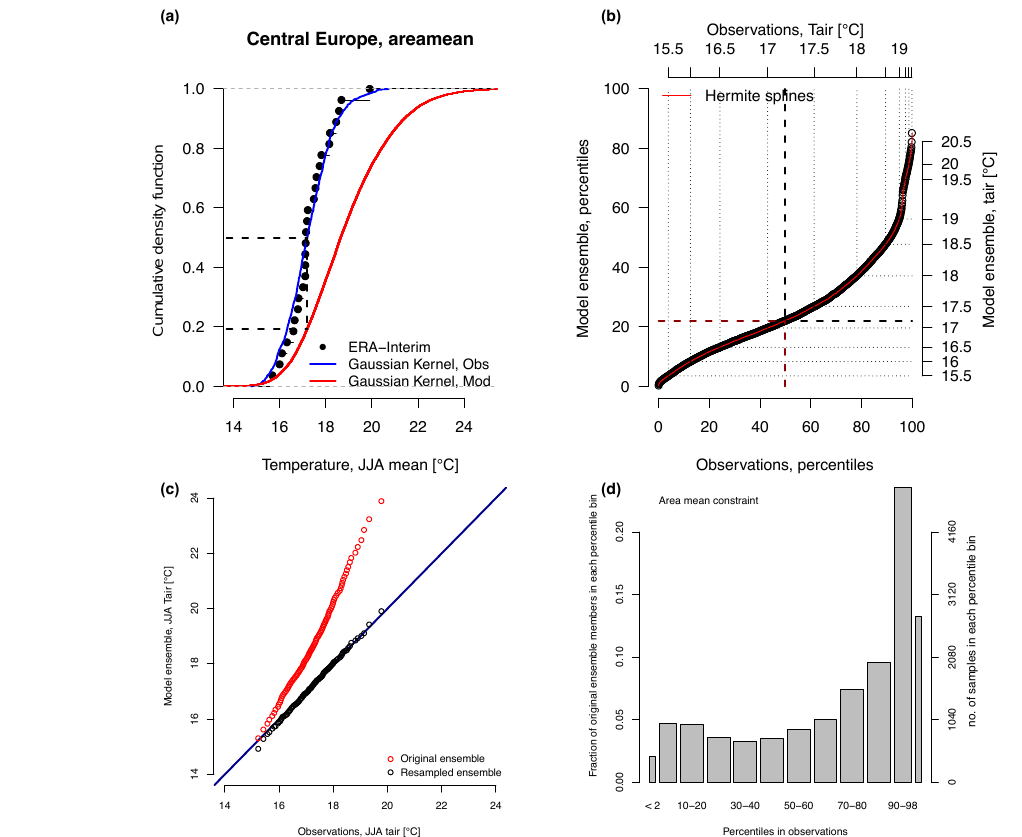
Figure 2. Illustration of ensemble-based resampling methodology. (a) Empirical cumulative density function of JJA mean temperatures over Central Europe in ERA-Interim. The nonparametric fit to the cumulative density using a Gaussian kernel for observations and the model ensemble are shown by the blue and red lines, respectively. (b) A transfer function between the observed and modelled distribution is derived using Cubic Hermite splines. (c) Quantile–quantile plot for the original and resampled ensemble for the JJA temperature constraint. (d) Fraction of original ensemble members in percentile bins of the observed distribution (blue line in (a) ), i.e. “effective ensemble size” after